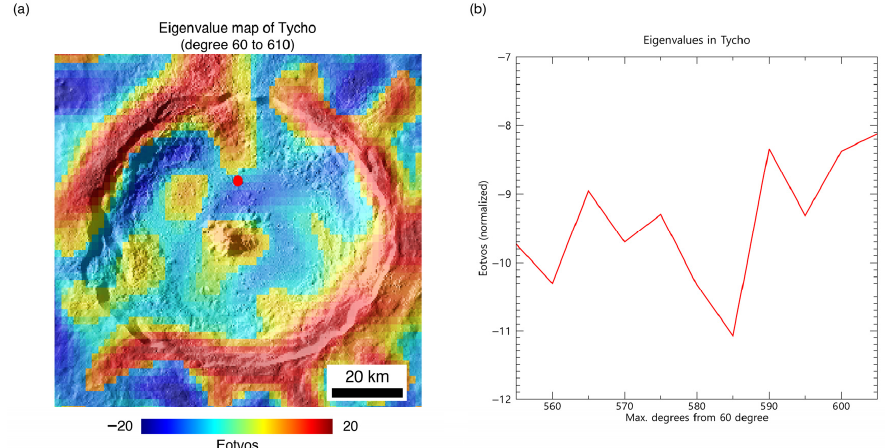
Figure 8. Eigenvalues map and eigenvalue variation of Tycho pit region. ( a ) Unlike other targets, a mass deficit appears only at one point and is located in a negative feature. ( b ) An oscillation pattern appears, but an increasing trend also appears.